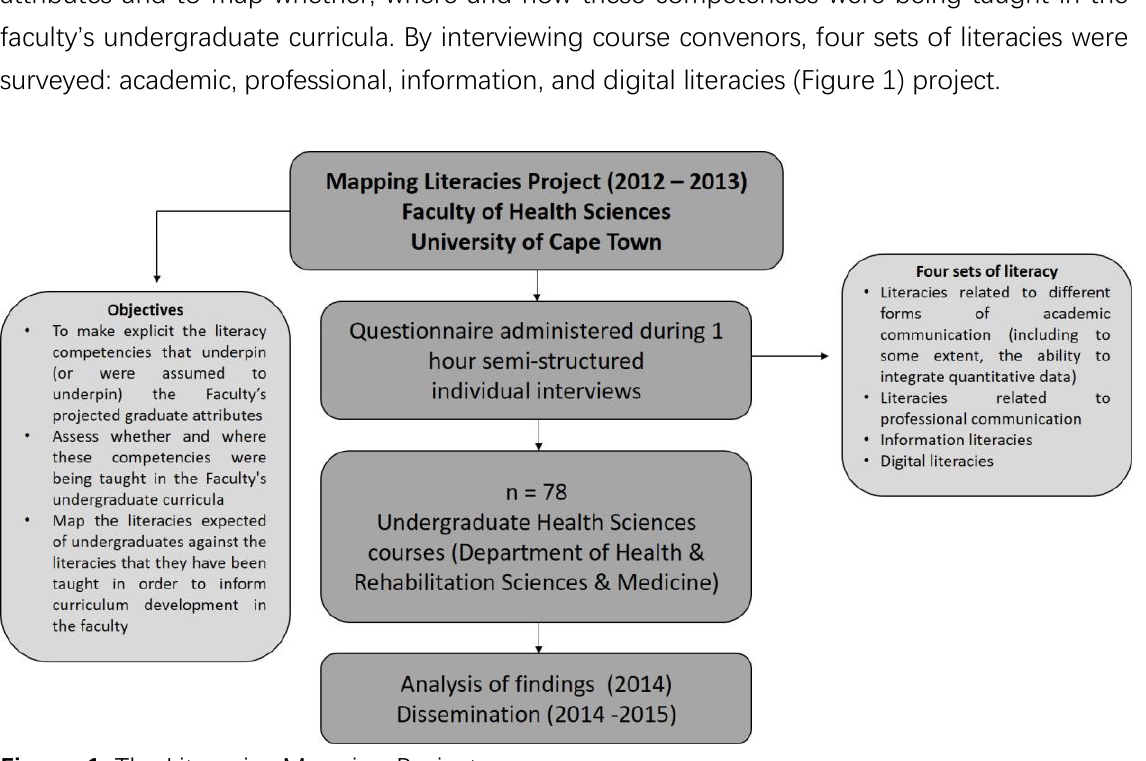
Figure 1 : The Literacies Mapping